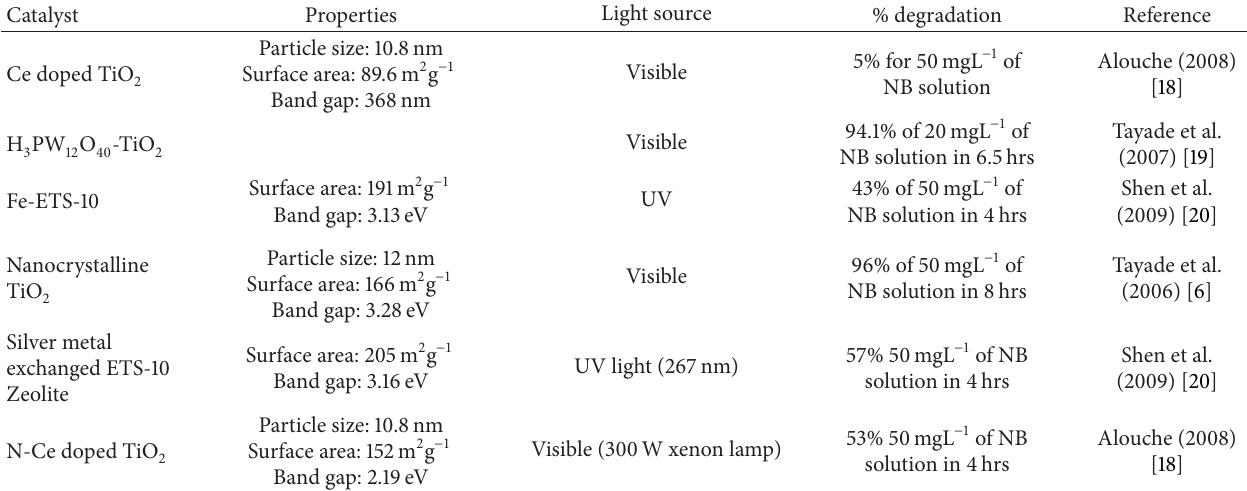
Table 3: Comparison of the performance of the present work with other published works.